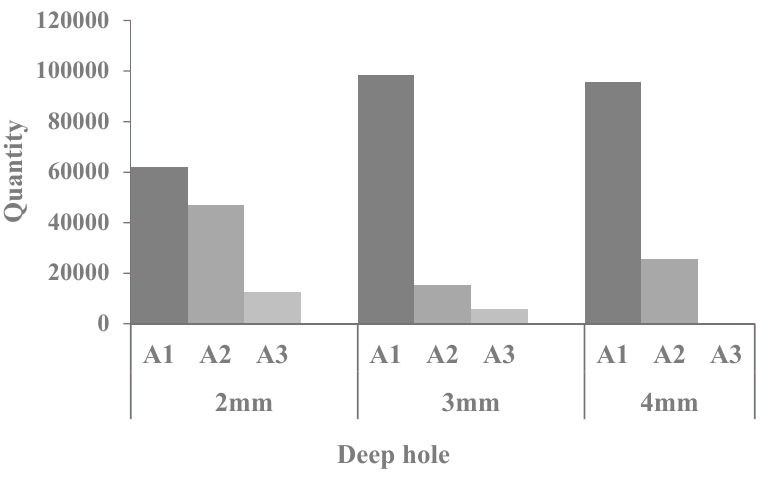
Figure 17. The quantity variation of debris.